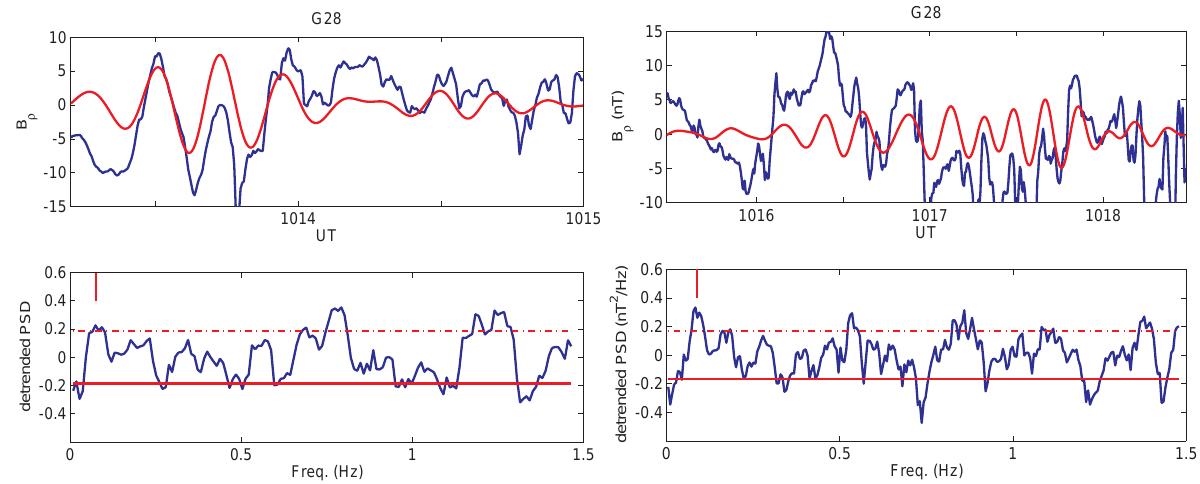
Fig. 4. At the bottom the detrended power spectrum is shown with the 95% confidence levels for the spectral peaks. The peaks for the cyclotron waves for O + (left) and O + (right) are indicated by short, red, vertical lines. At the top one of the transverse magnetic field 2 components ( B ρ ) is shown in blue with superimposed band-pass filtered data (red).